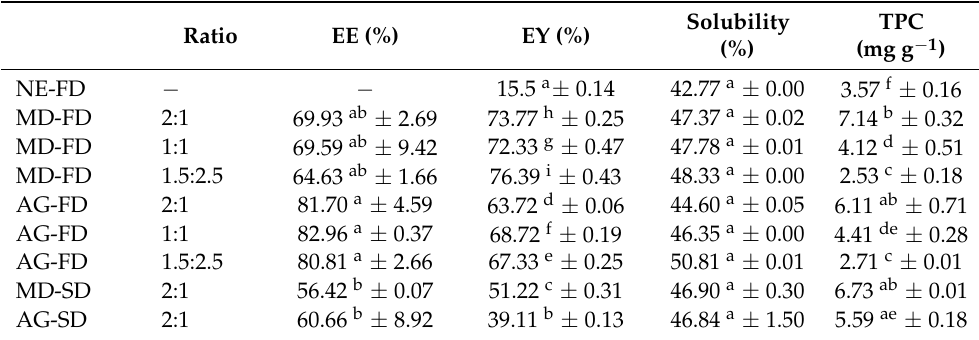
Table 3. Physicochemical parameters (mean ± SD) for the red dye extract non-encapsulated (NE) and extracts encapsulated with maltodextrin (MD) and Arabic gum (AG) obtained by freeze-drying (FD) and by spray-drying (SD) (mean ±